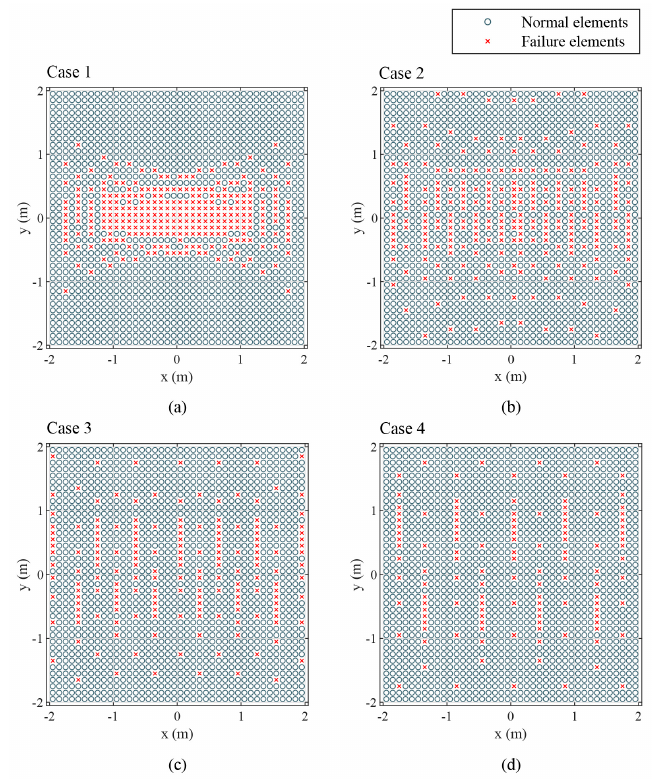
Figure 7. Failure diagrams of the phased-array antenna at different explosion distances: ( a ) 1 m, ( b ) 3 m, ( c ) 5 m, ( d ) 7